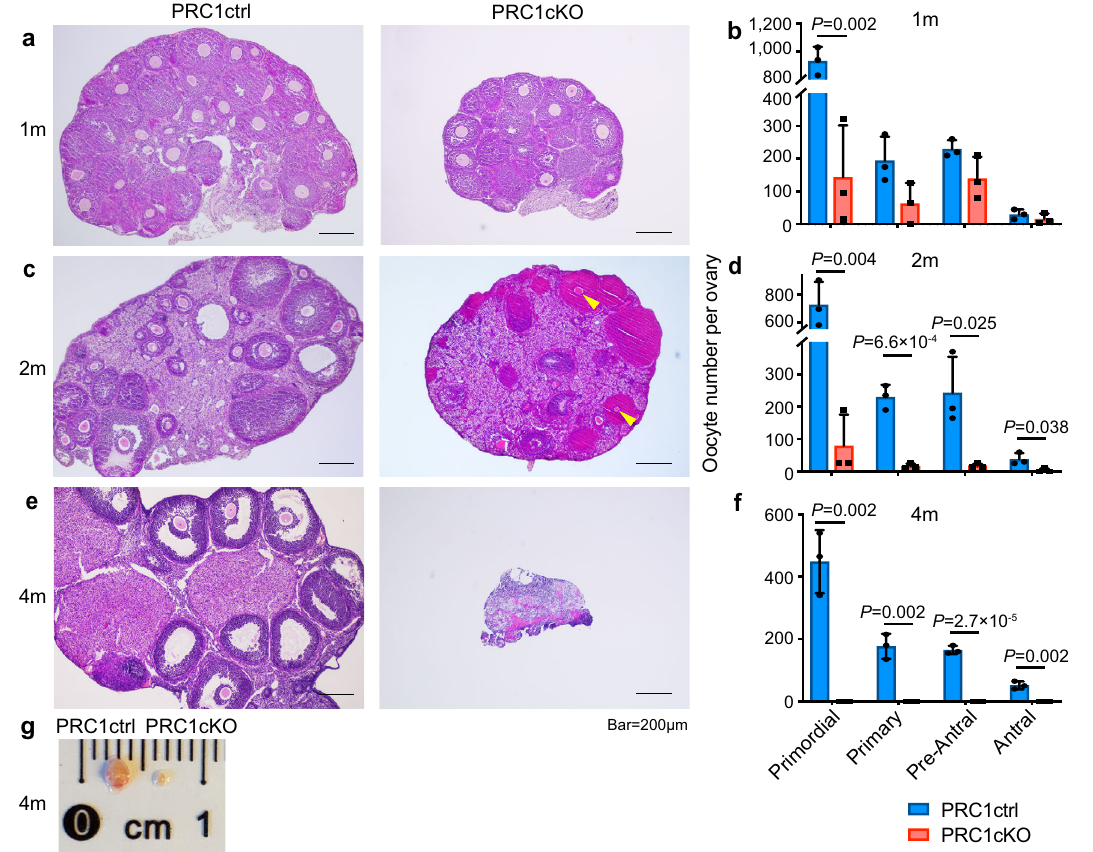
Fig. 2 Premature ovarian failure in PRC1cKO mice. a , c , e Histology of ovarian sections from PRC1ctrl and PRC1cKO females at 1 month, 2 months and 4 months of age, respectively, stained with hematoxylin & eosin. Yellow arrowheads point to atretic follicles. Bars: 200 μ m. For each time point, at least three mice of each genotype were used for analysis, and representative images are shown. b , d , f Quanti fi cation of the number of different type follicles per ovary from PRC1ctrl and PRC1cKO mice at the age of 1 month, 2 months and, 4 months, respectively. Primordial, Primary, Pre-Antral, and Antral follicles were counted. At least three mice were analyzed for each genotype at each time point. Data are presented as mean values ± SD. Two-tailed unpaired Student ’ s t-test. g A photo of ovaries from PRC1ctrl and PRC1cKO females at 4 months of age. Source data are provided as a Source Data fi